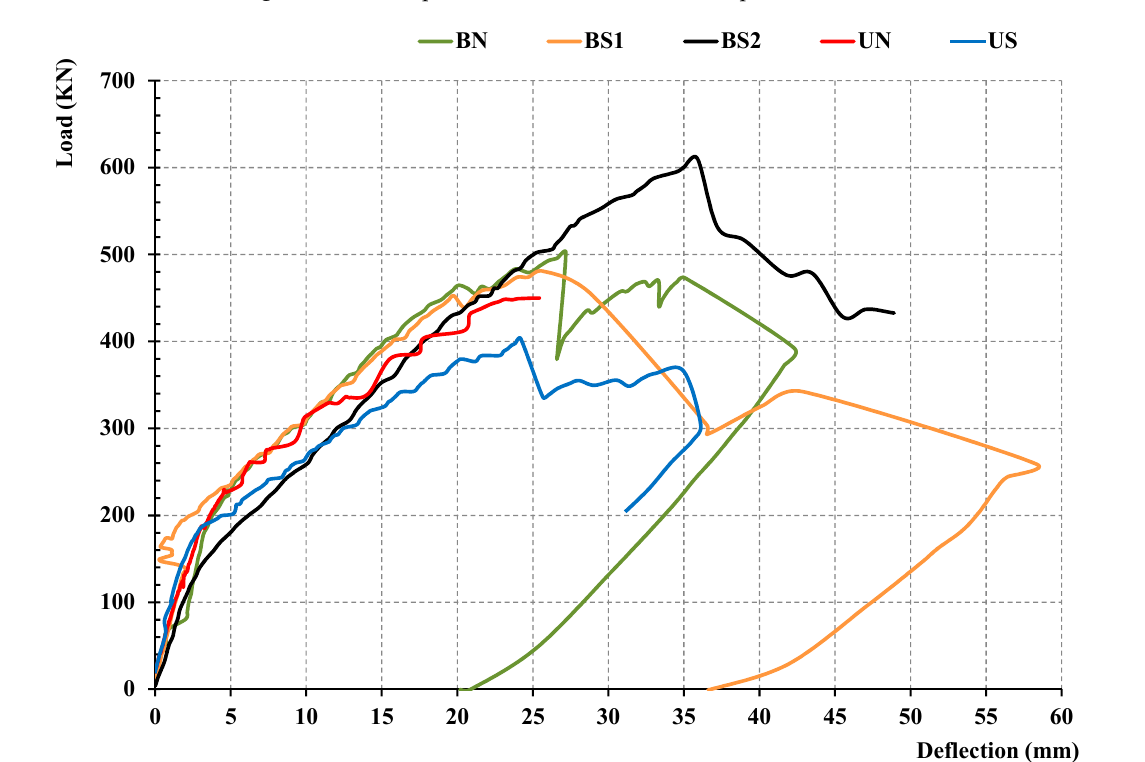
Figure 3. Load-deflection curve of all tested slabs [33]. Table 2. Cracking, ultimate loads and deflections for tested slabs.